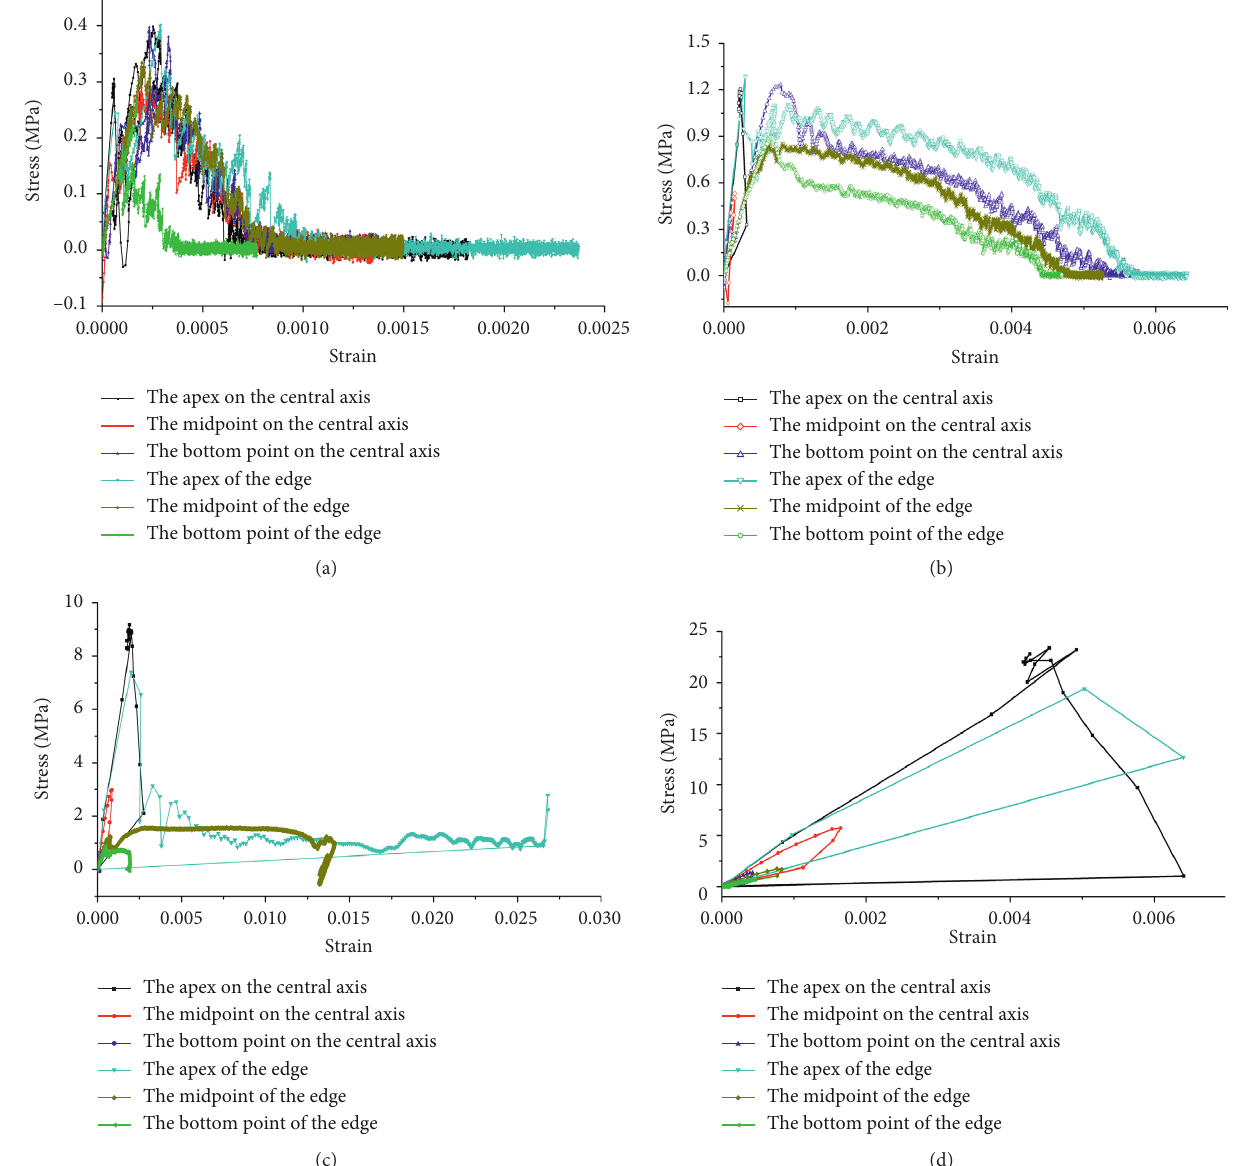
Figure 10: Element point axial stress-strain curve. Stress and strain at a speed of (a) 0.125m/s, (b) 0.5m/s, (c) 4m/s, and (d) 10